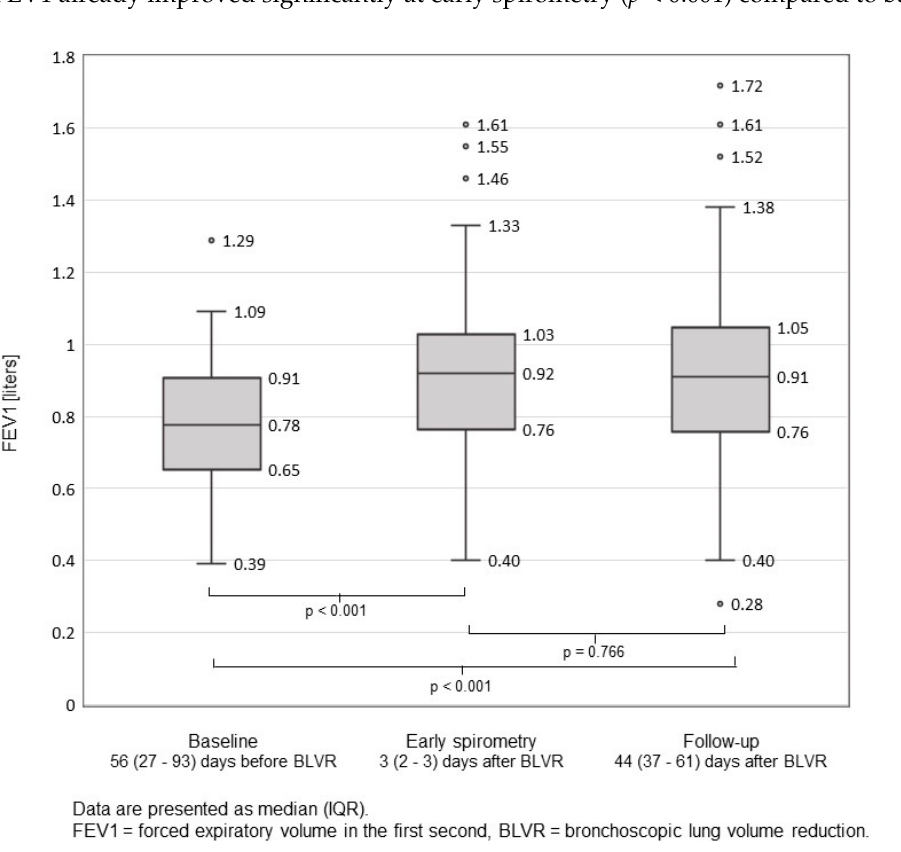
Figure 3. FEV1 at baseline, early spirometry, and follow-up after EBV treatment. Of the 61 cases with early spirometry, three were lost to follow-up spirometry.